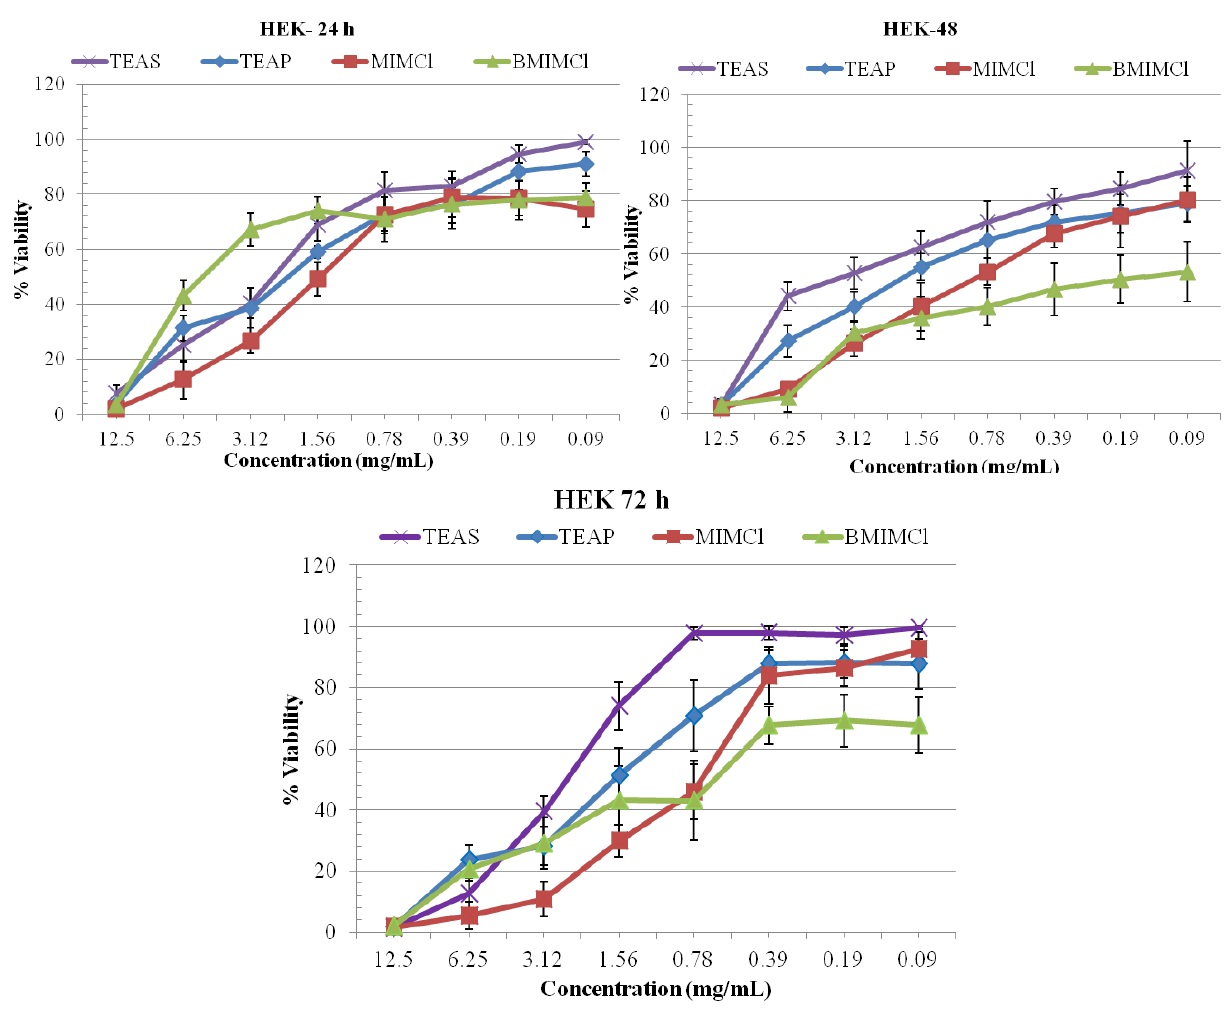
Figure 3. % Viability evaluated from MTT assay on normal HEK cells treated with ILs for 24, 48, and 72 h. All values are considered significant, when p <